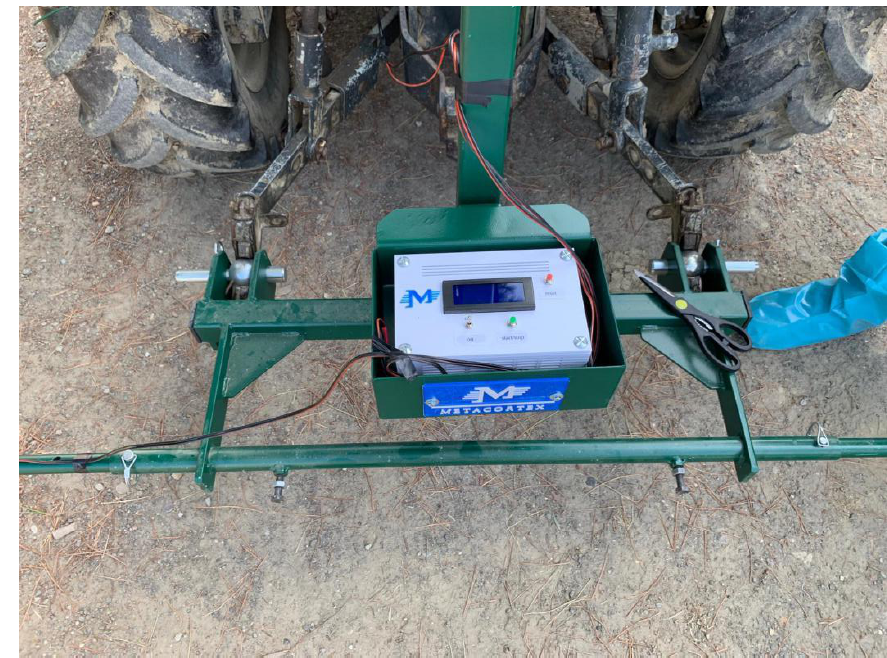
Figure 2. GPS module fixed on the bar.